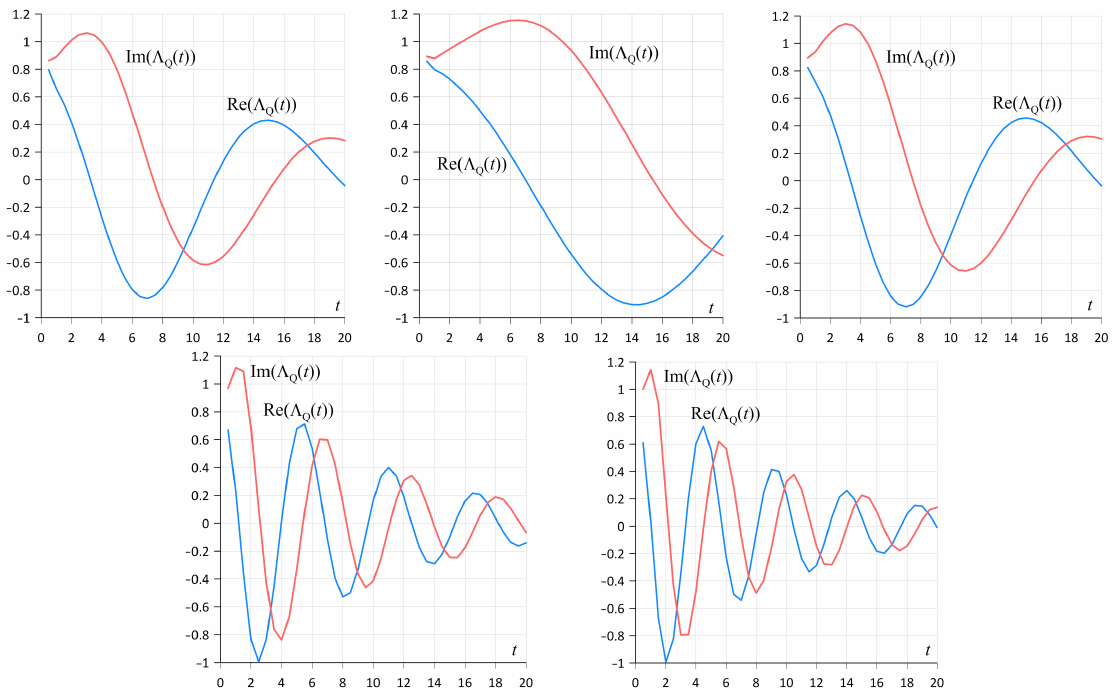
Figure 7. Mathematical expectations of the real (blue) and imaginary (red) parts of the oscillator trajectory for five sets of parameters. Left to right, front row: ( ε ( r ) = ε ( i ) = 0.01 ) , ( ε ( r ) = 1, ε ( i ) = 0.001 ) and ( ε ( r ) = 1, ε ( i ) = 0.01 ) ; in the second row: ( ε ( r ) = 1, ε ( i ) = 0.5 ) and ( ε ( r ) = ε ( i ) = 1 )